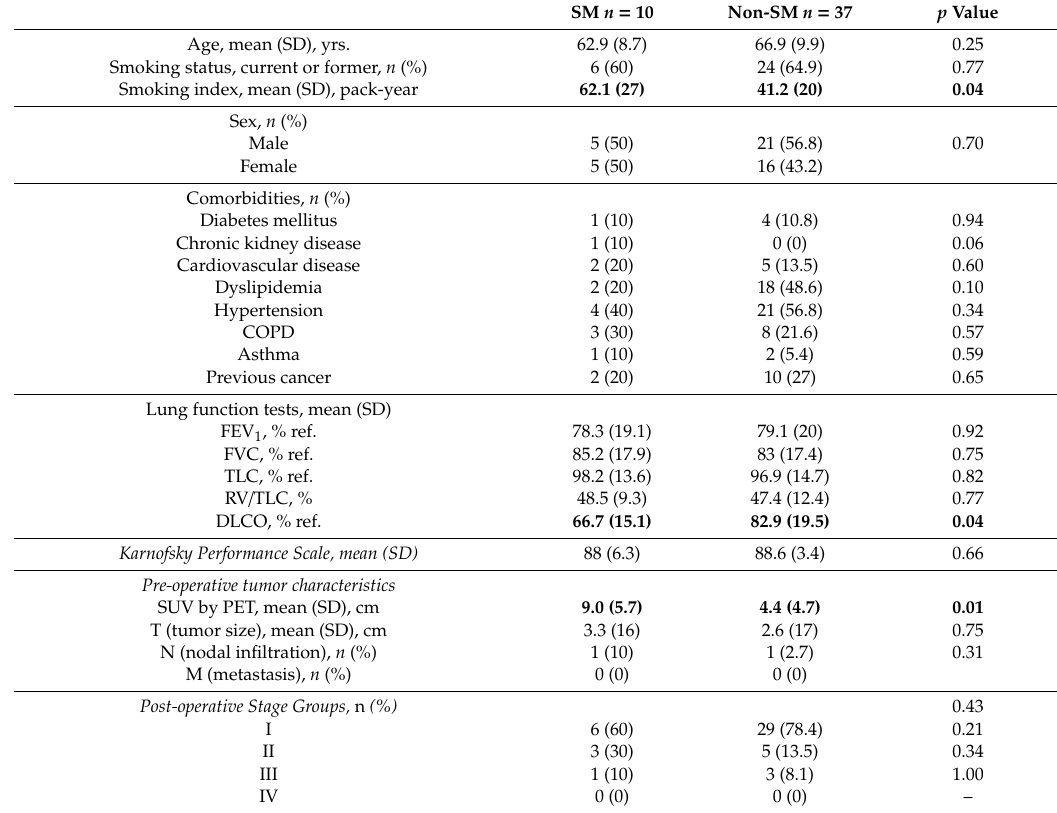
Table 1. Comparisons of Baseline characteristics in SM and non-SM